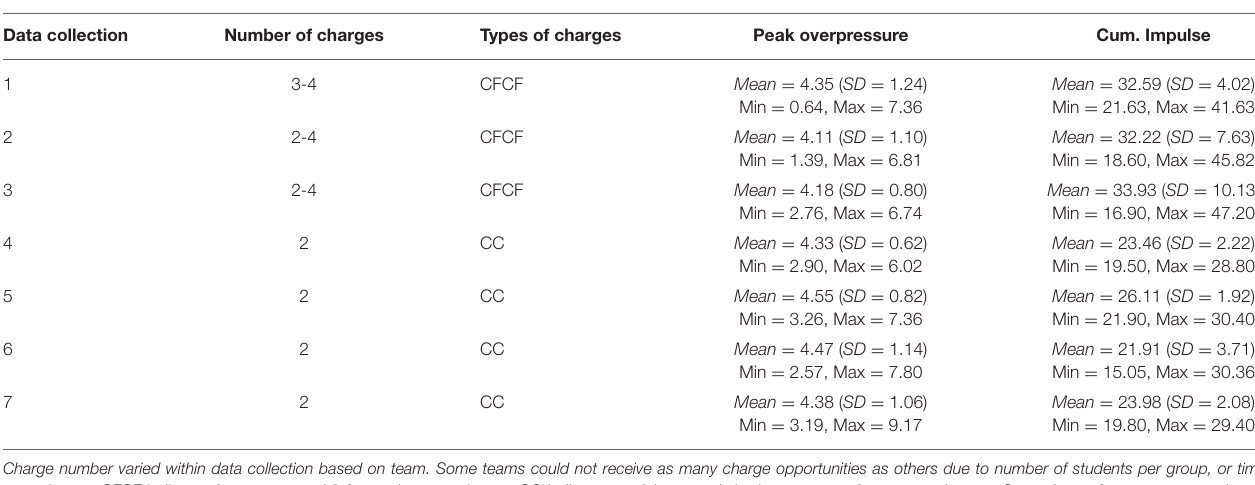
TABLE 1 | Characterization of blast by training course.